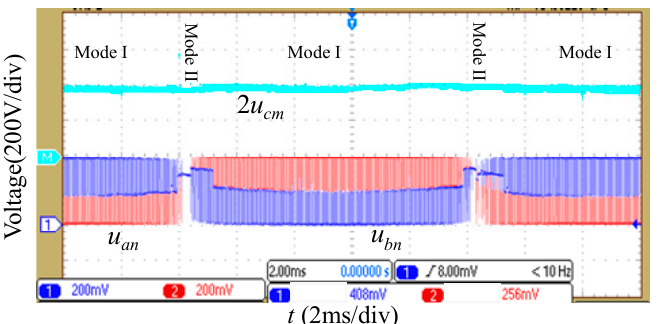
current . HMM: Grid voltage and current, θ = − 30°.